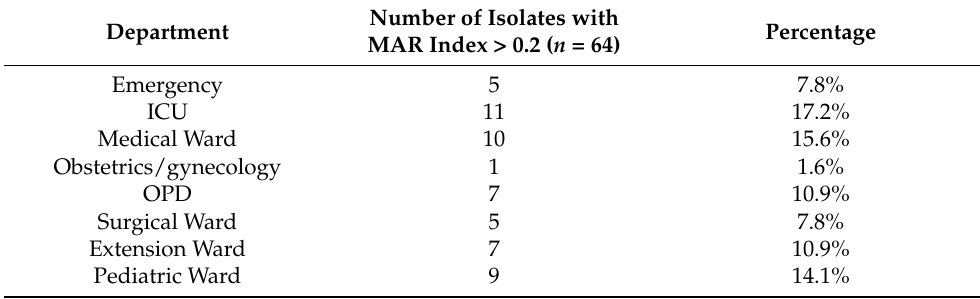
Table 3. Distribution of CoNS isolates depending on MARI value >0.2 in various departments.